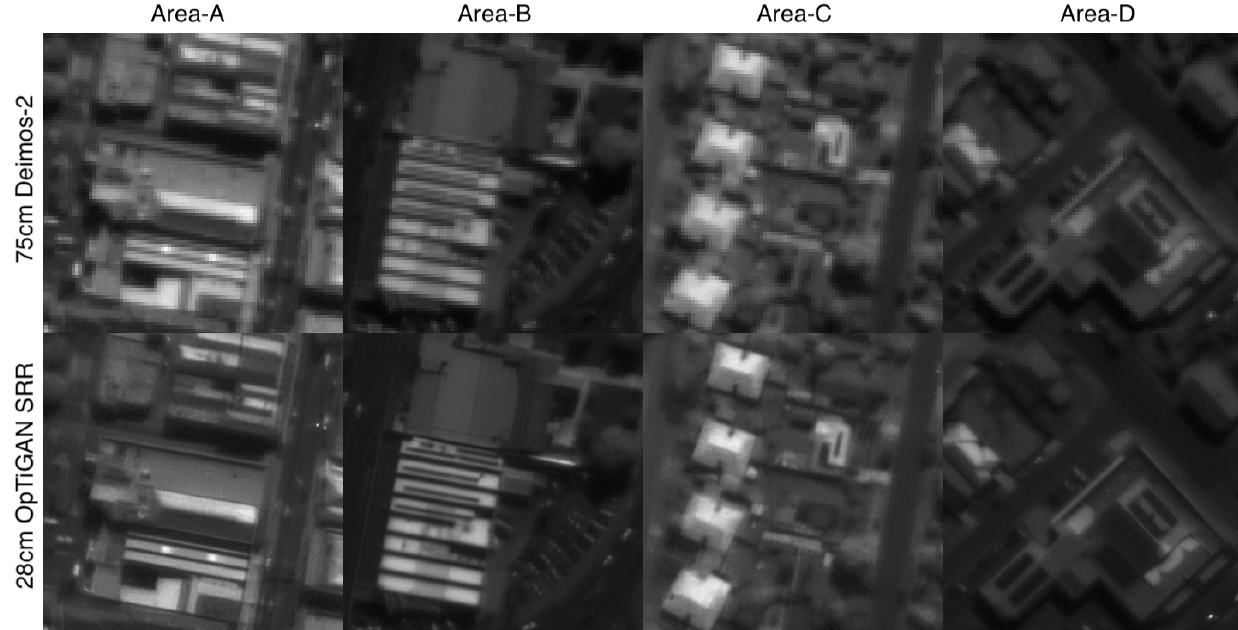
Figure 13. Examples of the 31 cm/pixel WorldView-3 image (20MAY16150148-P2AS-012860253010_01_P002) crops and the corresponding OpTiGAN SRR results showing snow surface features over a Greenland site. All sub-figures have a size of 27 m by 27 m. WorldView-3 image courtesy of Maxar 2020. Data provided by the European Space Agency.